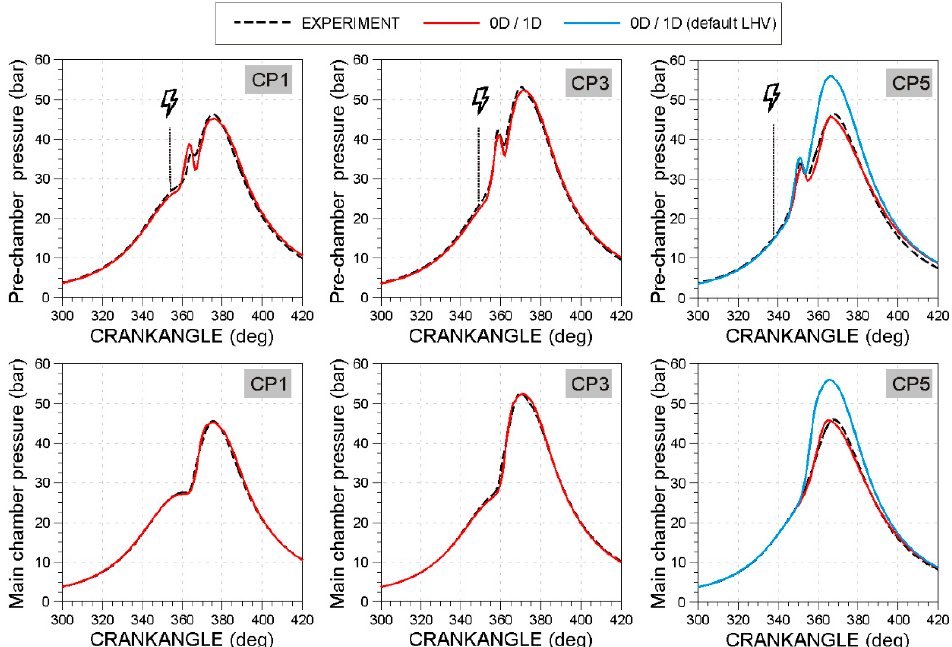
Figure 9. Experimental and 0D/1D simulation results of pressure traces in pre-chamber and main chamber for several calibration points.